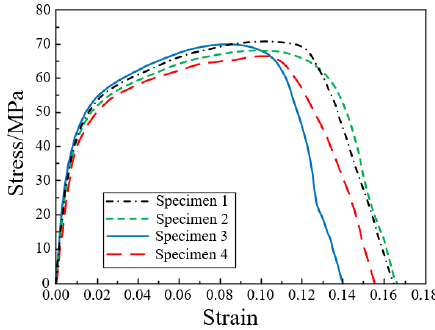
Figure 8. In-plane shear stress-strain curve at ±45° layer.